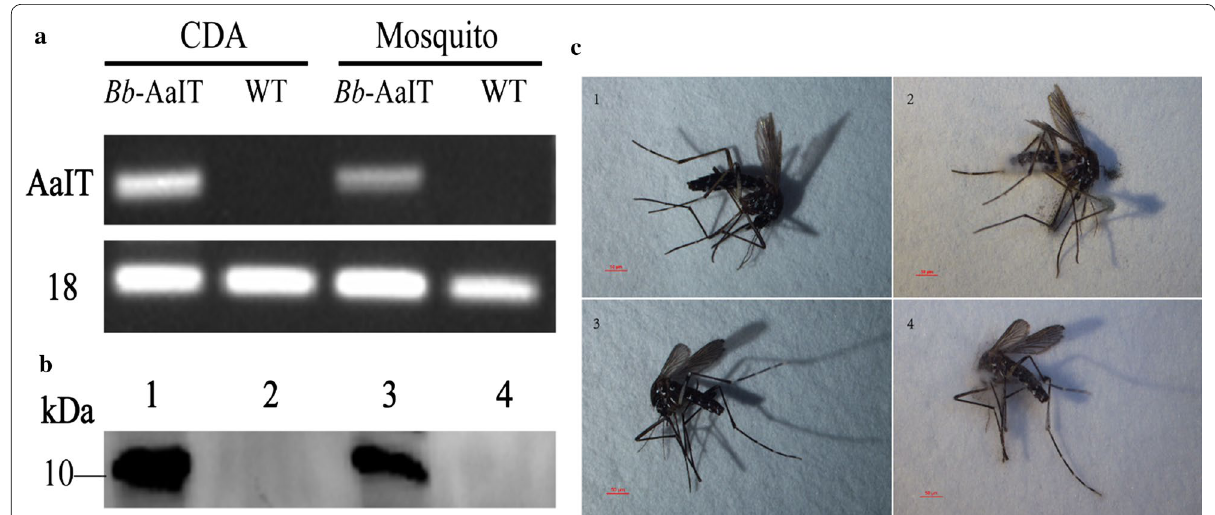
Fig. 1 Evidence for AaIT expression in the Bb ‑AaIT strain. a RT‑PCR detection of AaIT gene transcription in Bb ‑AaIT collected from the infected dead mosquitoes and the CDA with positive results, and in the WT control with negative results. The 18S rRNA was detected for the loading control. b Western blot detection of AaIT expression in Bb ‑AaIT and the WT with a polyclonal antibody against AaIT from different samples. Lane 1 , culture supernatant from Bb ‑AaIT grown in CDA for 4 days with a positive result; Lane 2 , culture supernatant from WT grown in CDA for 4 days with a nega‑ tive result; and Lane 3 , the dead female mosquitoes infected by Bb ‑AaIT and incubated at 25 °C for another 4 days. Lane 4 , the dead female mosqui‑ toes infected by the WT and incubated at 25 °C for another 4 days. c The dead female mosquitoes were infected by Bb ‑AaIT or WT through conidial ingestion. Fungal outgrowths were not observed in the uncultured dead mosquitoes ( 1 and 3 ), and typical fungal outgrowths were observed on the dead mosquitoes that were infected by Bb ‑AaIT ( 2 ) and the WT ( 4 ) after 4 days of incubation at 25 °C and saturated humidity. Bars , 50